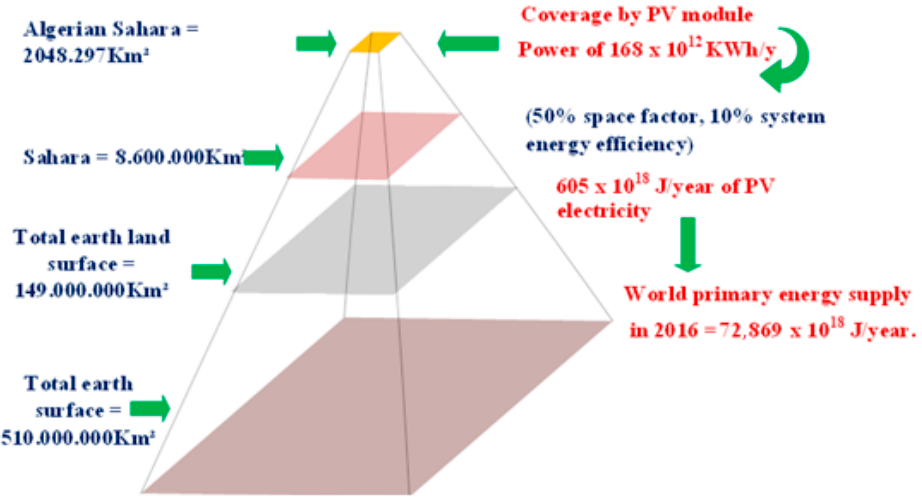
Figure 9. Potential solar generation for the Sahara Desert.